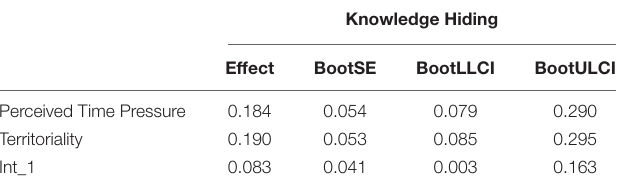
TABLE 6 | Regression coefficients and